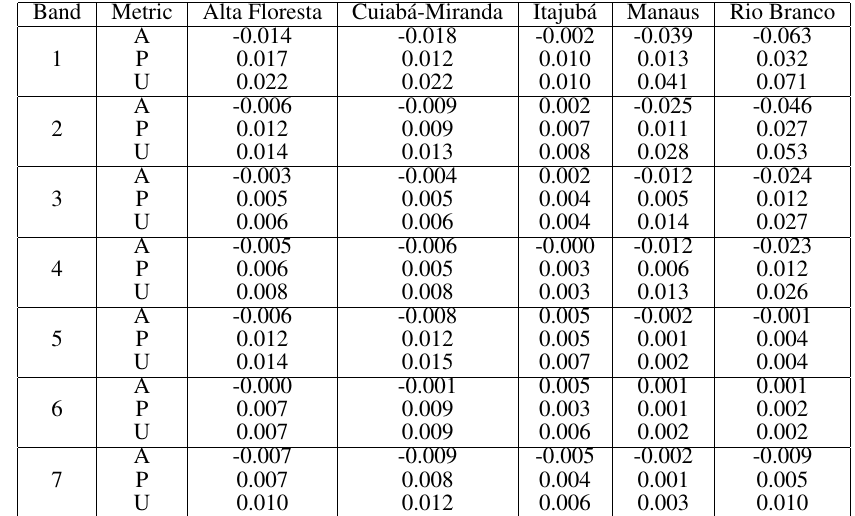
Table 2. Landsat-8/OLI LaSRC surface accuracy (A), precision (P) and uncertainty (U) comparison between and reference data over all the sites.